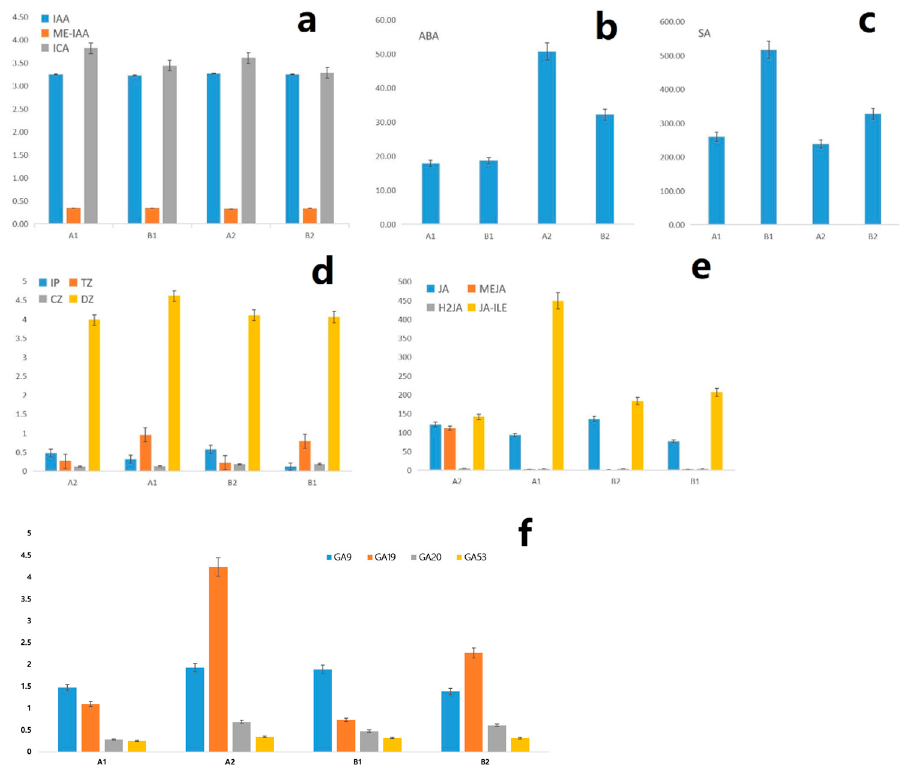
Figure 8. Difference of phytohormones content between the CMF and IMF of C. mollissima. A1. The CMF in post-winter; B1: The IMF in post-winter; A2: The CMF in pre-winter; B2: The IMF in pre-winter. ( a ) Changes of auxin content in different flower buds; ( b ) Change of abscisic acid content; ( c ) Change of salicylic acid content; ( d ) Change of cytokinin content; ( e ) Changes of methyl jasmonate content; ( f ) Change of gibberellin content.